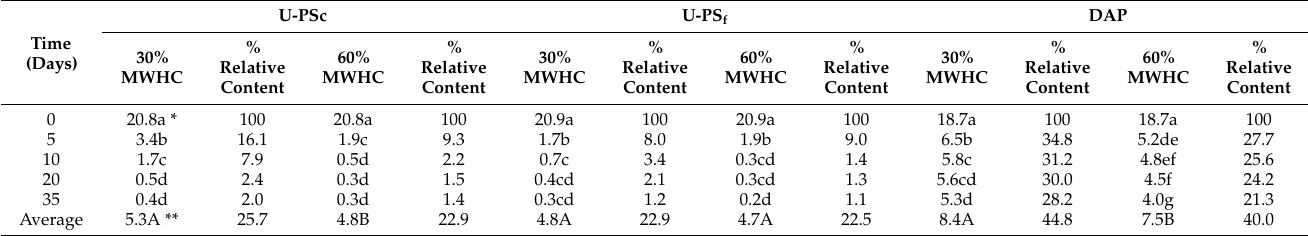
Table 3. Effect of incubation time and soil moisture on the release rate of total nitrogen from mineral fertilizers (%N in dry mass).